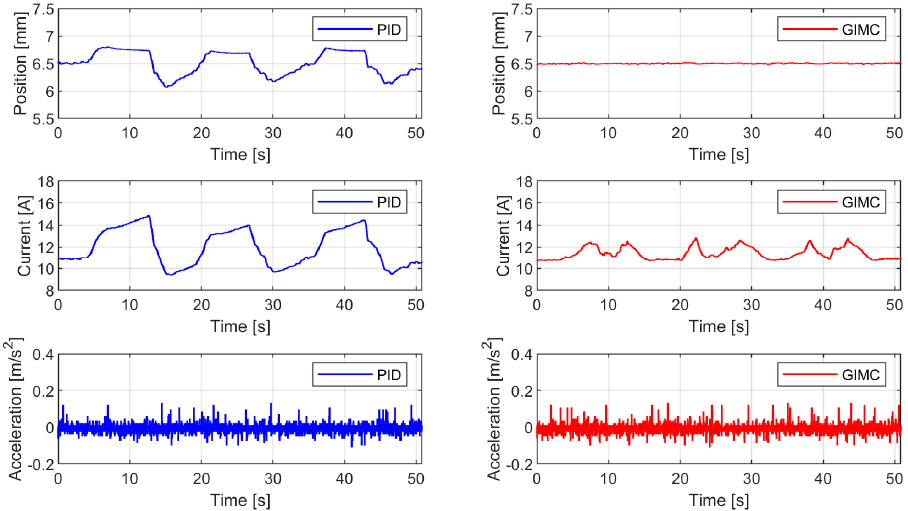
Figure 19. The experimental results in the small-scale experimental platform.